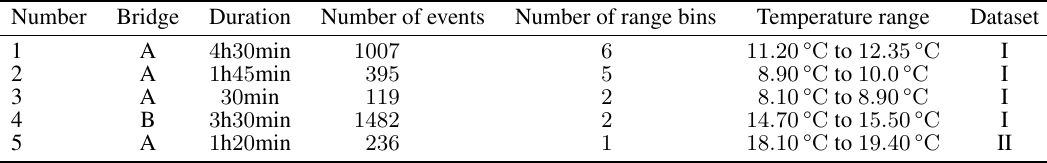
Figure 2. The displacement time series of three consecutive events for four range bins on bridge A. All events are highlighted and pictures of the corresponding vehicles, acquired with a UAV, are attached. The leading truck causes the bridge to vibrate even after leaving the bridge deck. Both following cars lead to a bending of the bridge which is superimposed with the oscillation. Table 2. Overview of the measurement campaigns at the bridges conducted for this study. The duration refers to the period of measurements at the respective bridge, number of events to the number of crossing vehicles, and number of range bins to the number of bins selected for analysis. The temperature range covers the air temperature during the measurements. Dataset I consists of the training, validation, and test subsets necessary for the ML approaches; while dataset II is an extra test subset, which is entirely unknown to the ML